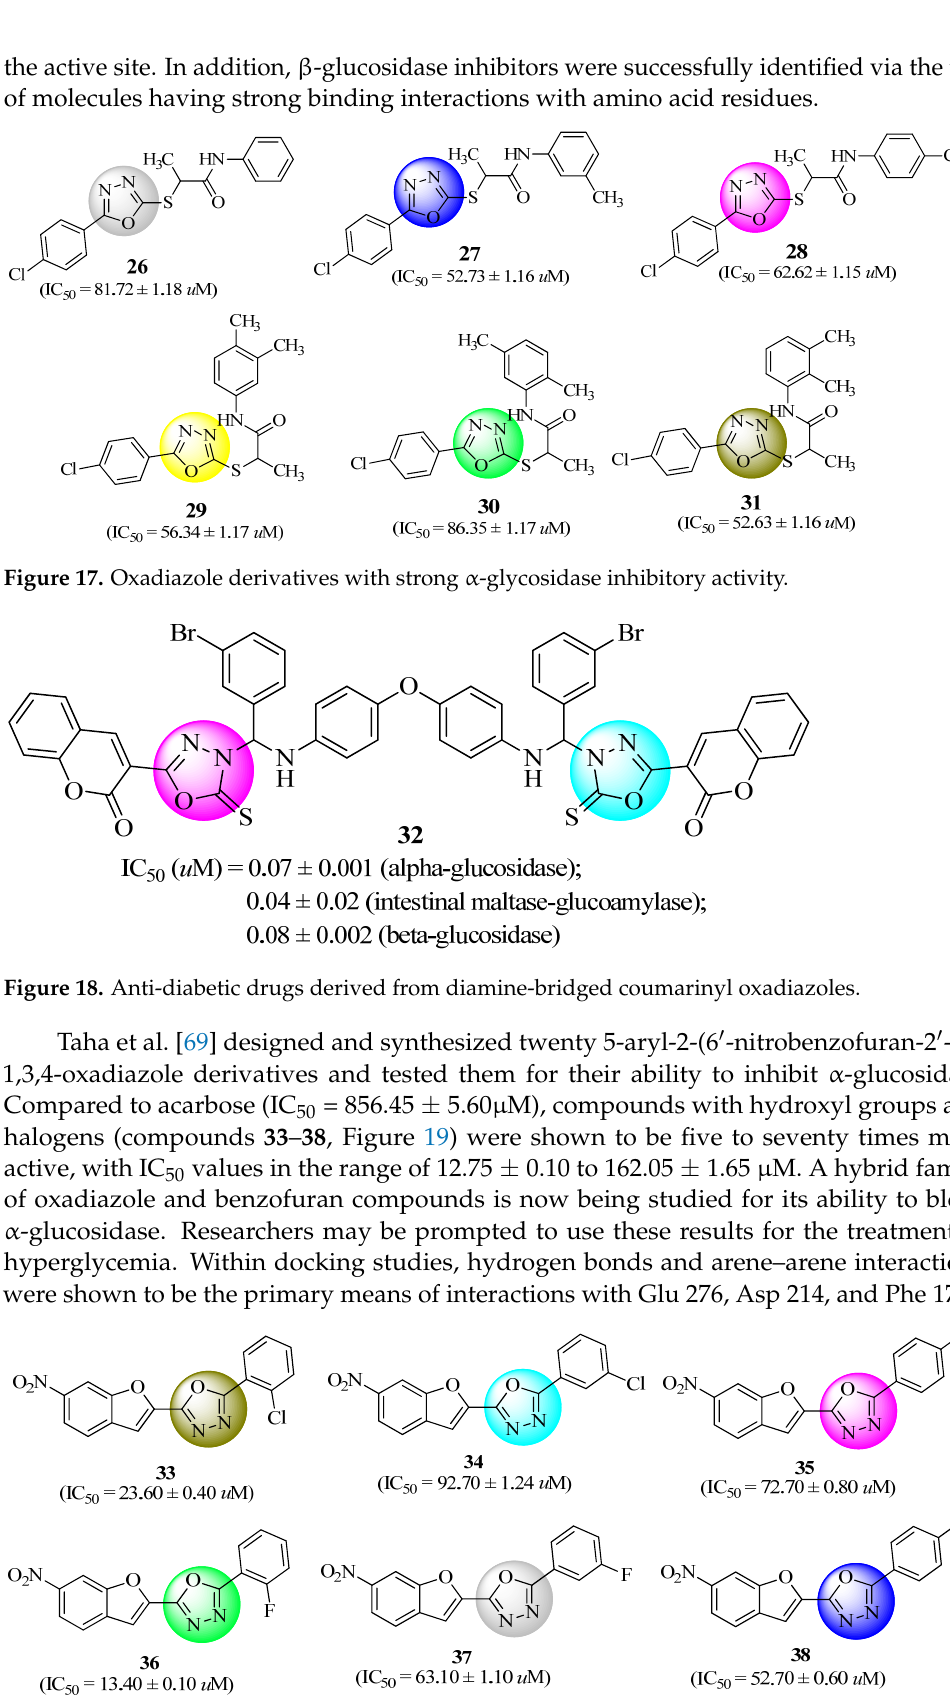
Figure 19. Nitrobenzofuran-1,3,4-Oxadiazoles derivatives.